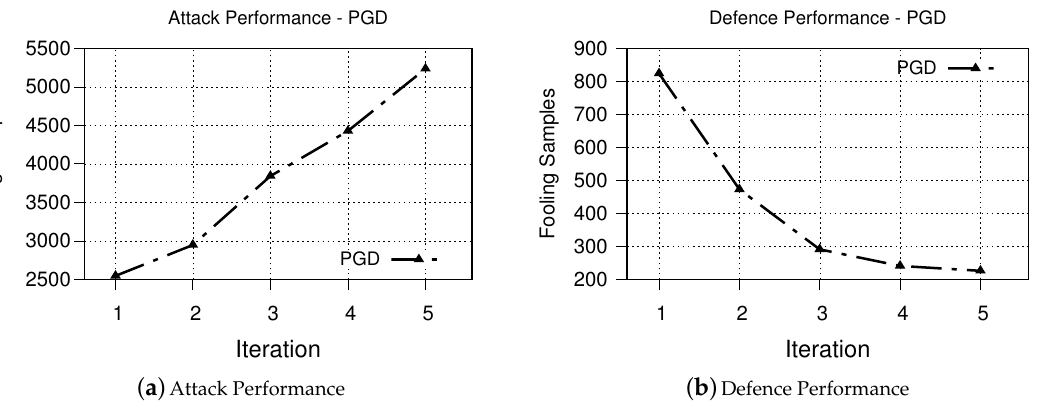
Figure 7. The results of DeepFool.